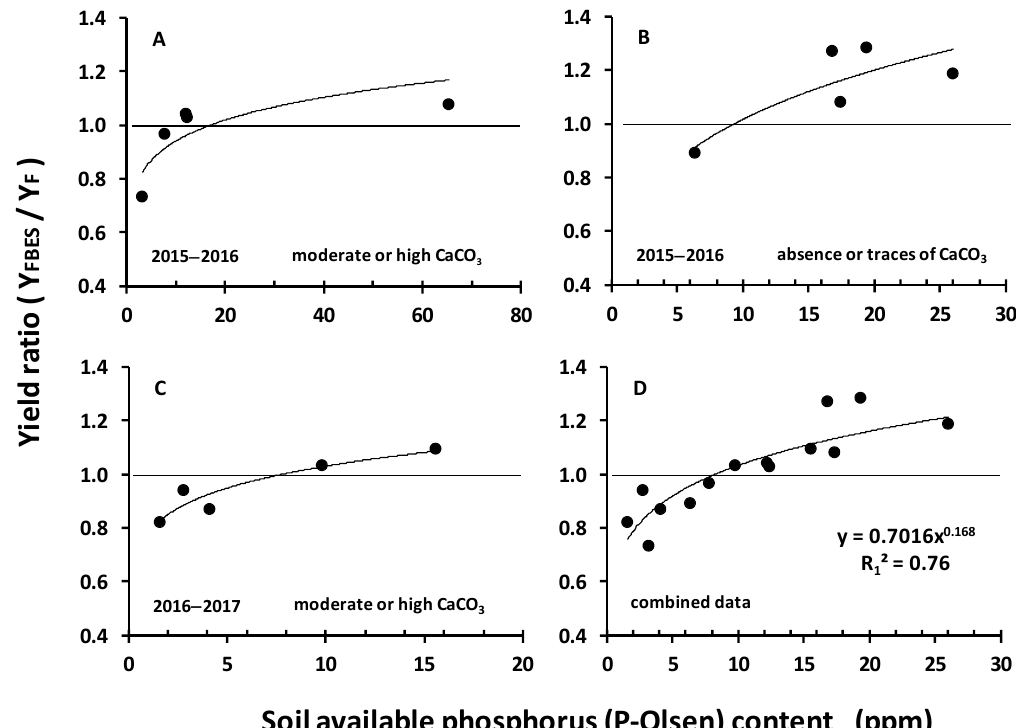
Figure 2. The relationship between the yield ratio (YFBES/YF) and available phosphorus content in the soil. YF, yield of the conventional crop; YFBES, yield of the elemental sulfur treated crop. ( A ) Wheat growing season in 2015–2016: Field trials with moderate of high calcium carbonate content (Group A2). ( B ) Wheat growing season in 2015–2016: Field trials lacking calcium carbonate content (Group A1). ( C ) Wheat growing season in 2016–2017: Field trials with moderate of high calcium carbonate content (Group A3). ( D ) The combination of data.